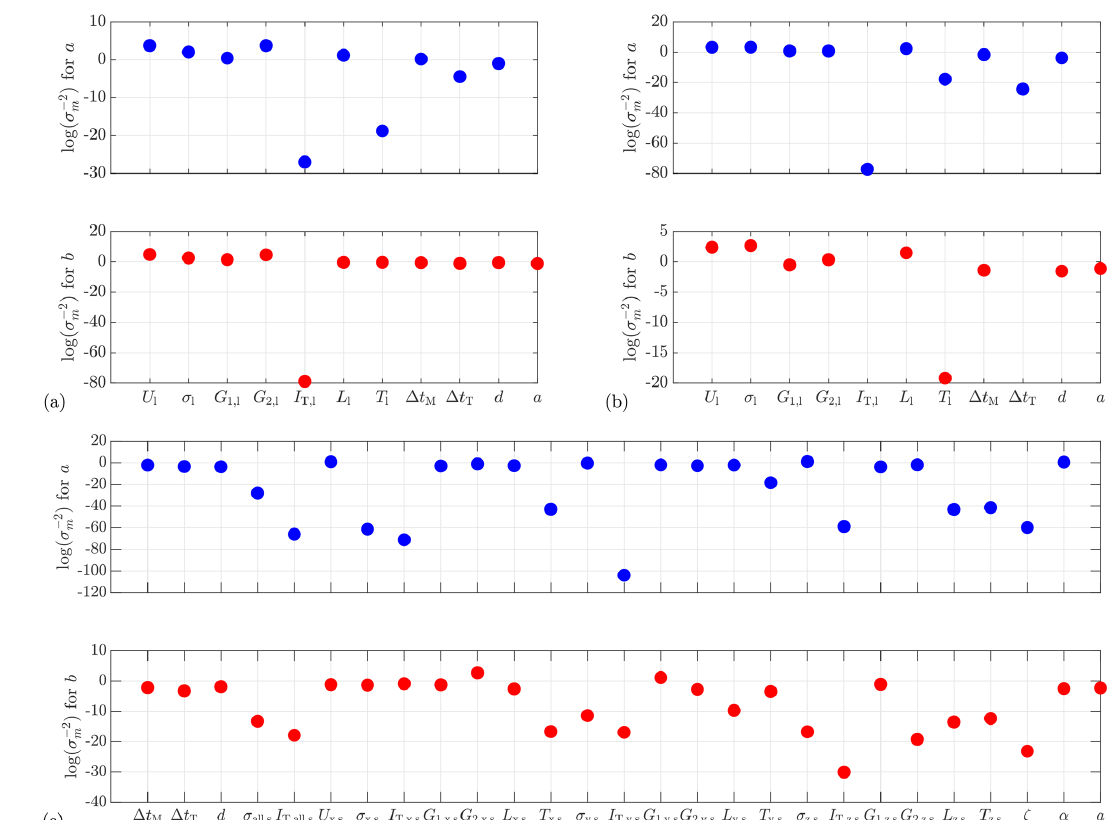
Figure 10. Comparison of the relative importance of predictors. (a) ParkCast, lidar data. (b) Lidar Complex, lidar data. (c) Lidar Complex, sonic data. log( σ − 2 m ) = −∞ is not